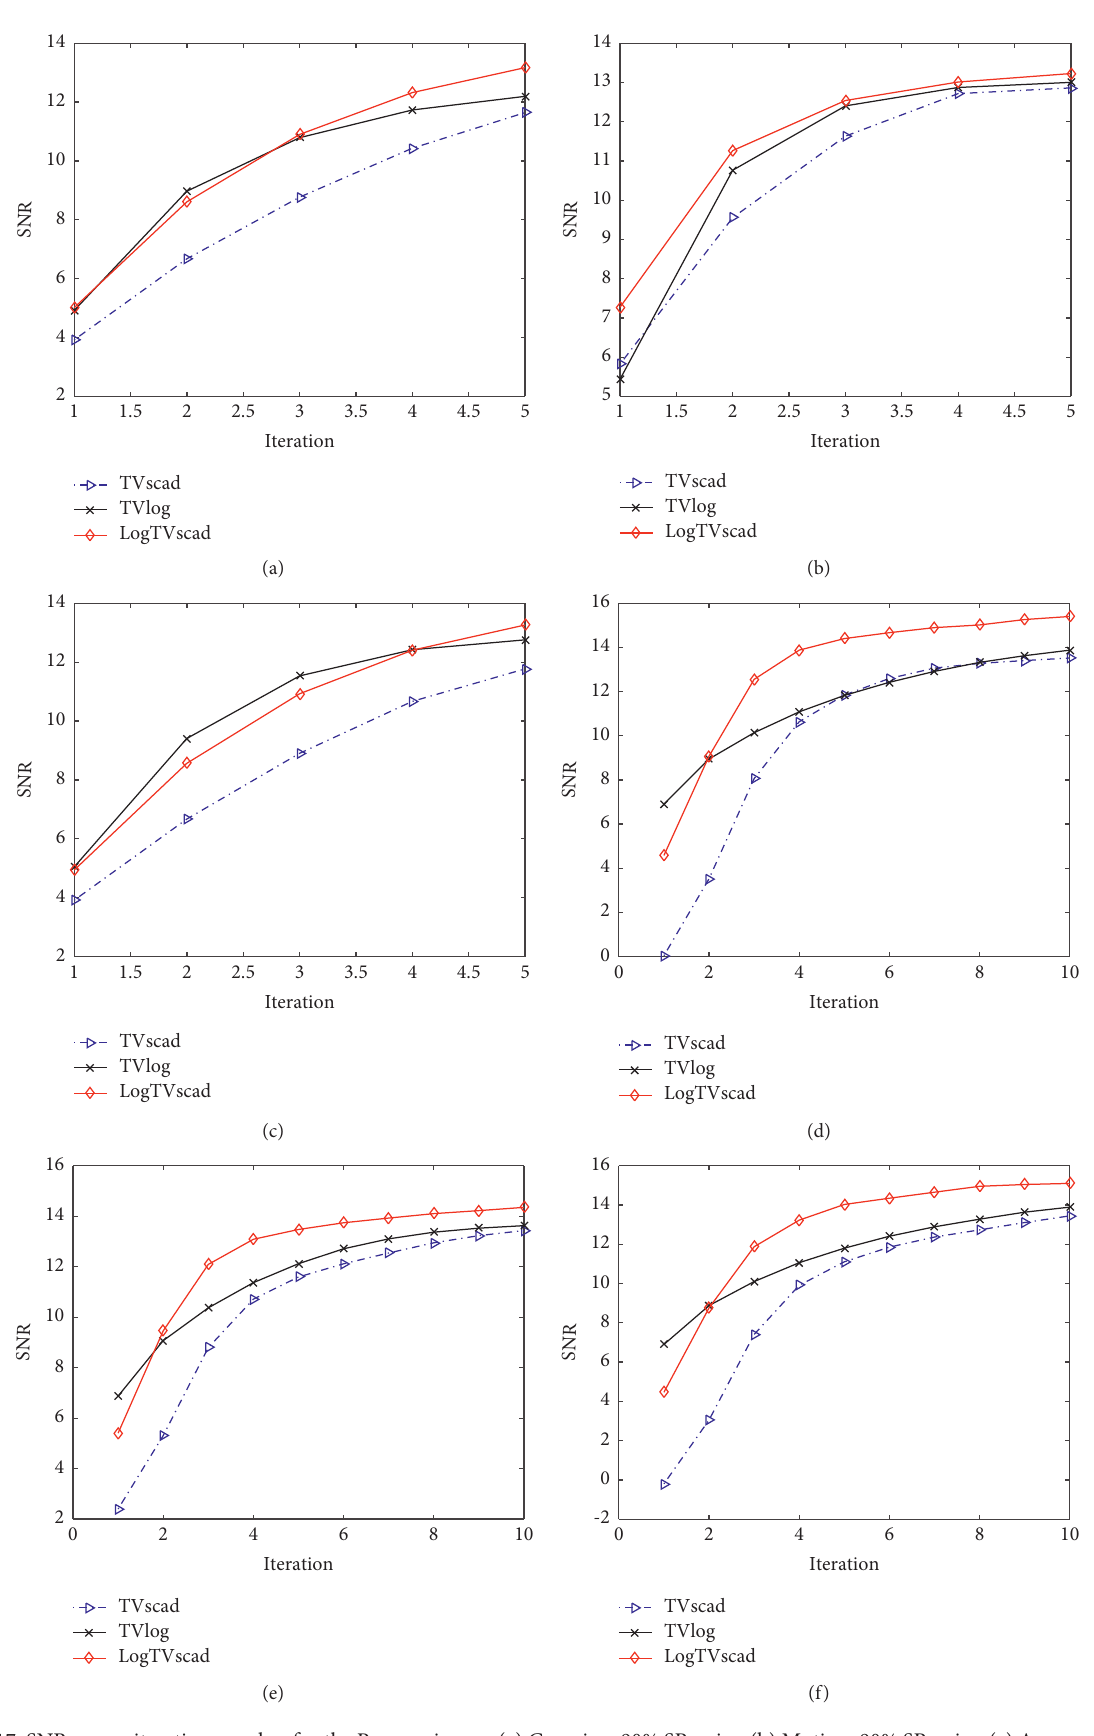
Figure 17: SNR versus iteration number for the Peppers image. (a) Gaussian, 90% SP noise. (b) Motion, 90% SP noise. (c) Average, 90% SP noise. (d) Gaussian, 70% RV noise. (e) Motion, 70% RV noise. (f) Average, 70% RV